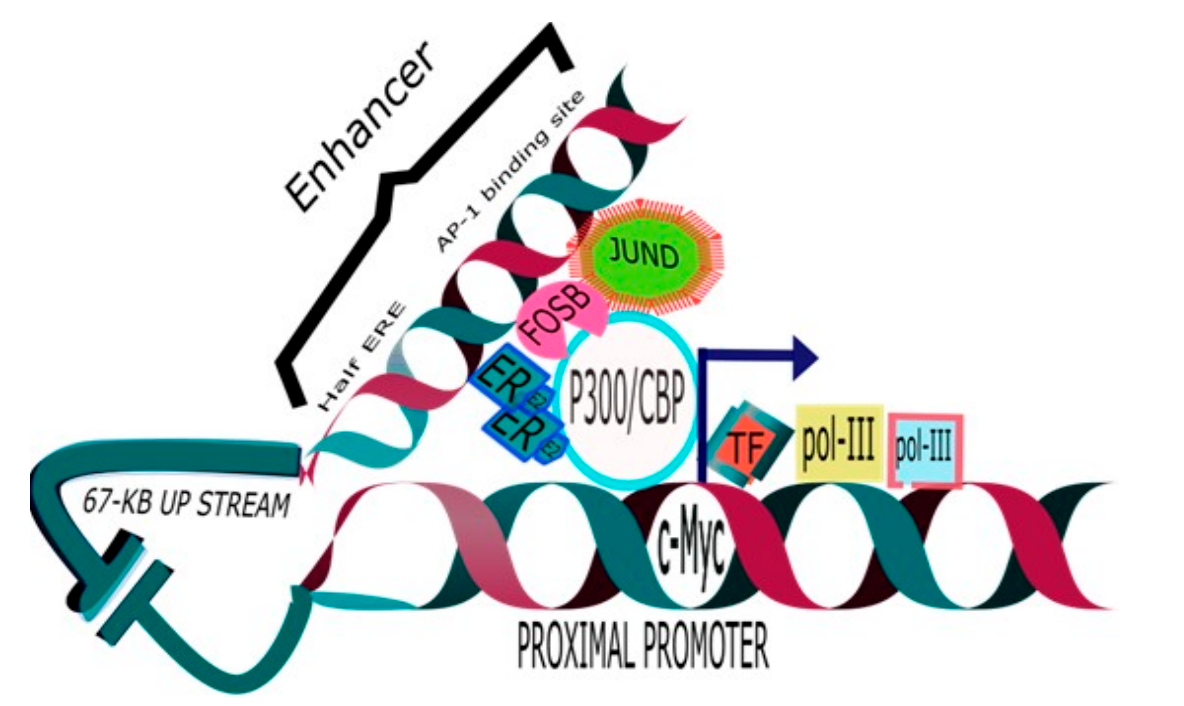
Figure 1. Binding of estradiol with estrogen receptor in collaboration of JunD and FOSB acts as enhancer 1.7 KB upstream of c-myc.